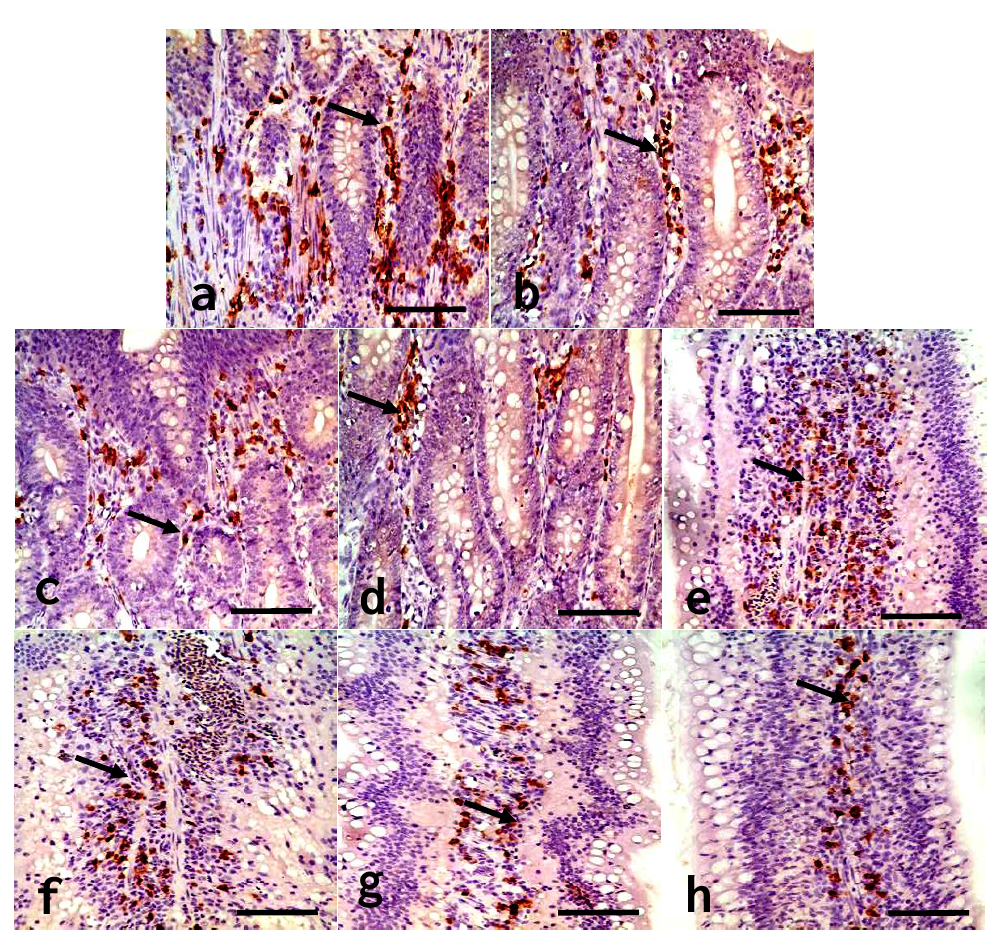
Figure 1. IgA + B cells in the crypts and lamina propria of villi in the duodenum at 42 days of age. ( a ) The duodenal crypts in the control group. ( b ) The duodenal crypts in the 300 mg/kg group. ( c ) The duodenal crypts in the 600 mg/kg group. ( d ) The duodenal crypts in the 900 mg/kg group. ( e ) The duodenal lamina propria in the control group. ( f ) The duodenal lamina propria in the 300 mg/kg group. ( g ) The duodenal lamina propria in the 600 mg/kg group. ( h ) The duodenal lamina propria in the 900 mg/kg group. (SABC, bar = 50 μm).